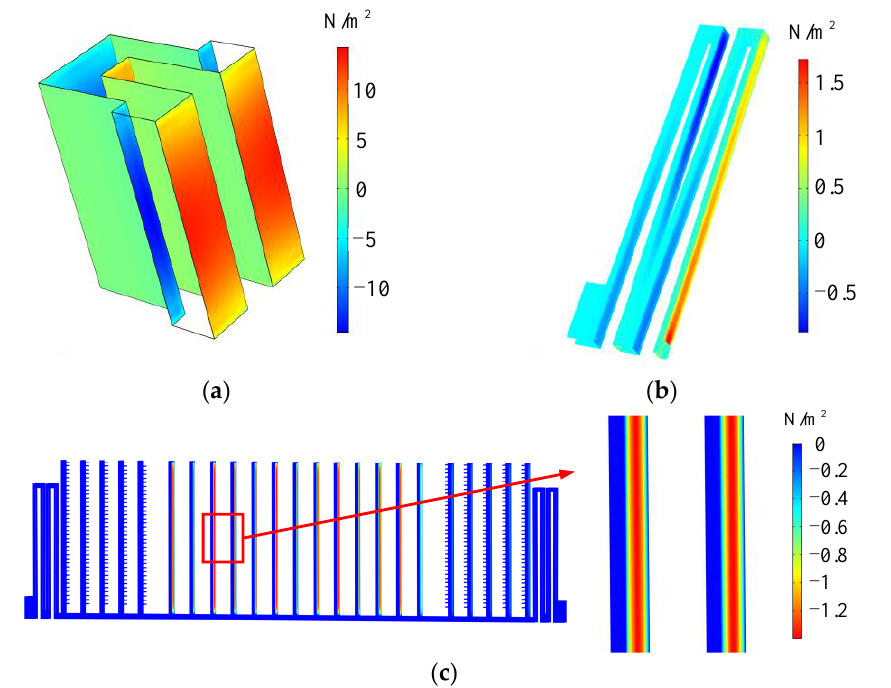
Figure 9. The fluid load distribution: ( a ) incompressible flow load distribution of the comb tooth unit; ( b ) incompressible flow load distribution of the folded-flexure suspension; ( c ) viscous flow load distribution of the shutters.